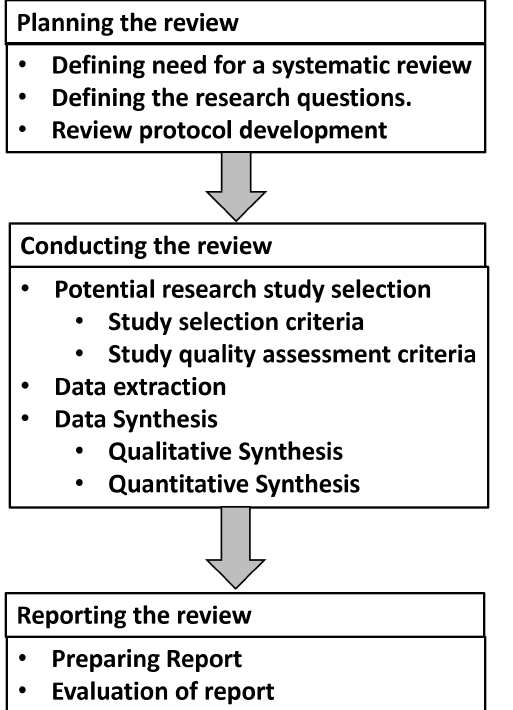
Figure 2. Systematic Literature Review steps. Systematic Literature Review steps shown with the help of four boxes and connecting